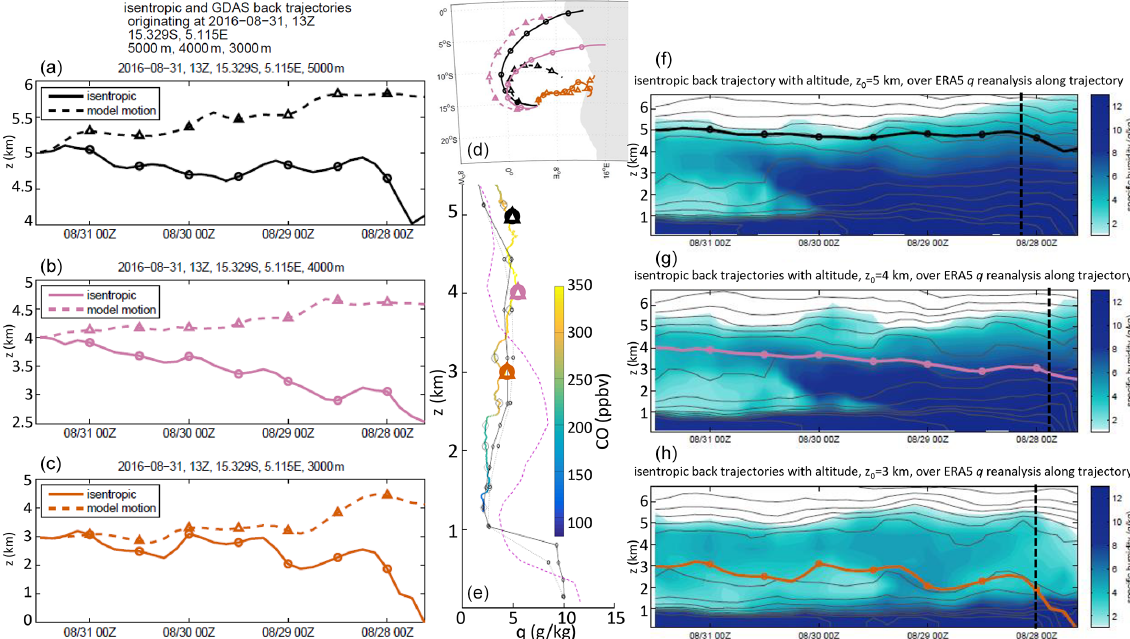
Figure 17. As in Fig. 16, for three trajectories initialized from a profile from 31 August 2016 13:00Z which showed more uniform q and CO with altitude than the profile on 10 September. Back trajectories are initialized at (a, f) 5km, (b, g) 4km, and (c, h) 3km altitudes. As the isentropic and kinematic trajectories significantly diverge from one another in latitude and longitude, the trajectories in (f) – (h) show ERA5 values along the isentropic trajectories only. The altitudes of both back trajectories in time are shown in (a) – (c) .